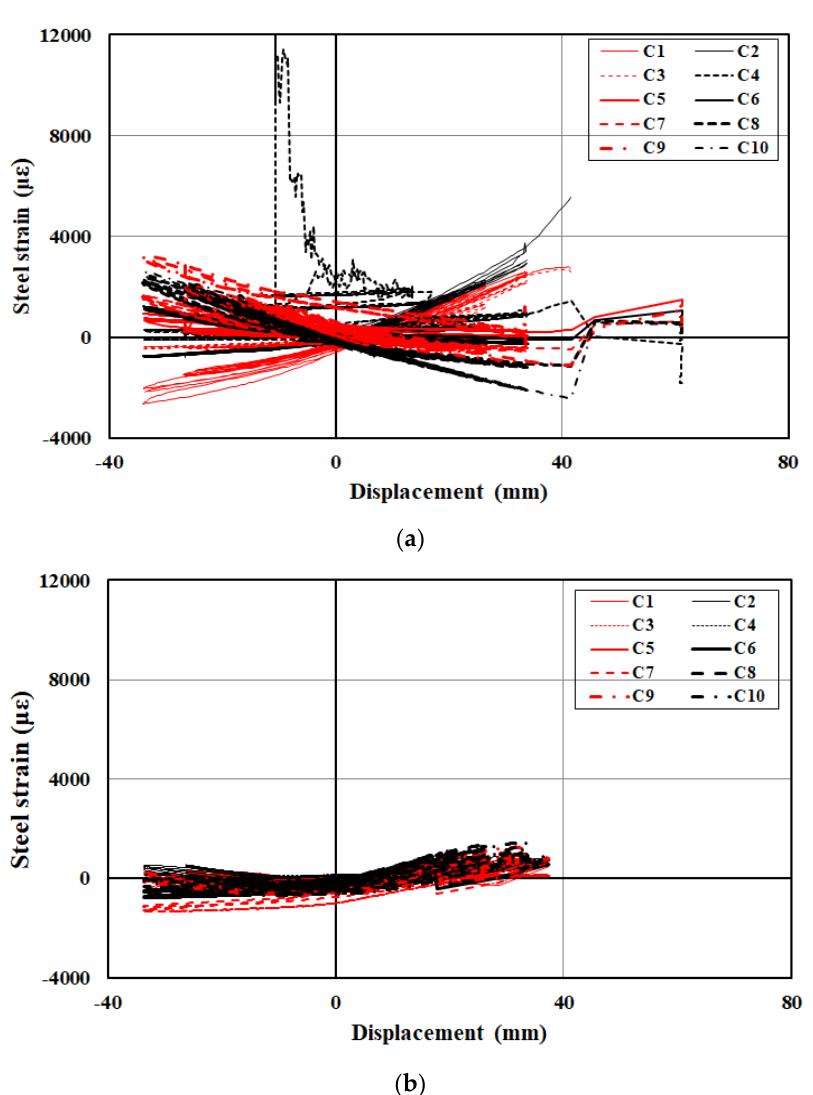
Figure 19. Strain of the main steel bars. ( a ) Without WKDS, ( b ) With WKDS.